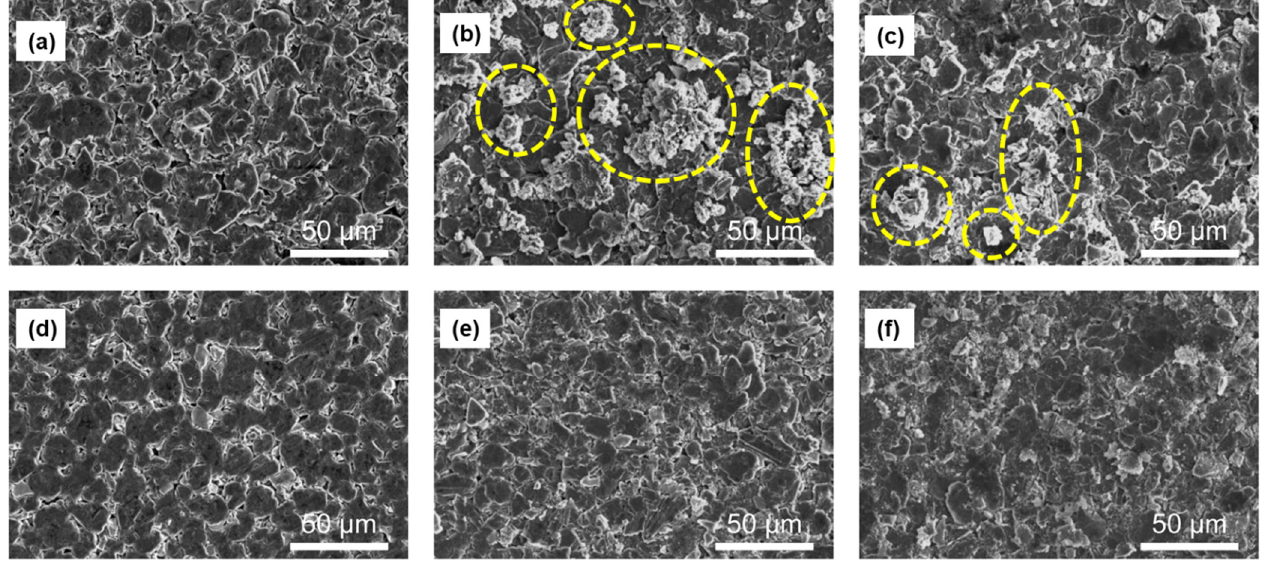
Figure 3. Top-view SEM images of ( a – c ) SiMP blending and ( d – f ) SiO x blending electrodes in full-cell: ( a ) pristine, ( b ) after 250 cycles, ( c ) after 500 cycles, respectively.